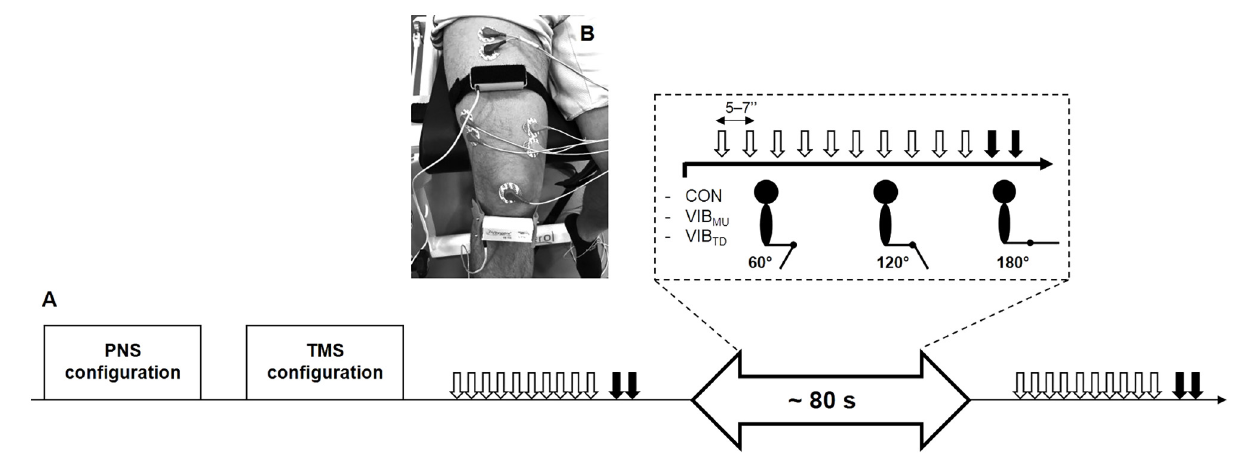
FIGURE 1 | Overview of the experimental protocol (A) . Series of ten transcranial magnetic (white arrows) and two peripheral nerves stimulations (black arrows) were performed at three different muscle lengths (i.e., corresponding to knee angles of 60, 120, and 180 ◦ ) for the three conditions, i.e., no vibration (CON), muscle vibration (VIB MU ), and tendon vibration (VIB TD ). Illustration of the position of the vibratory devices on the rectus femoris muscle and the infrapatellar tendon at a knee angle of 120 ◦ (B)